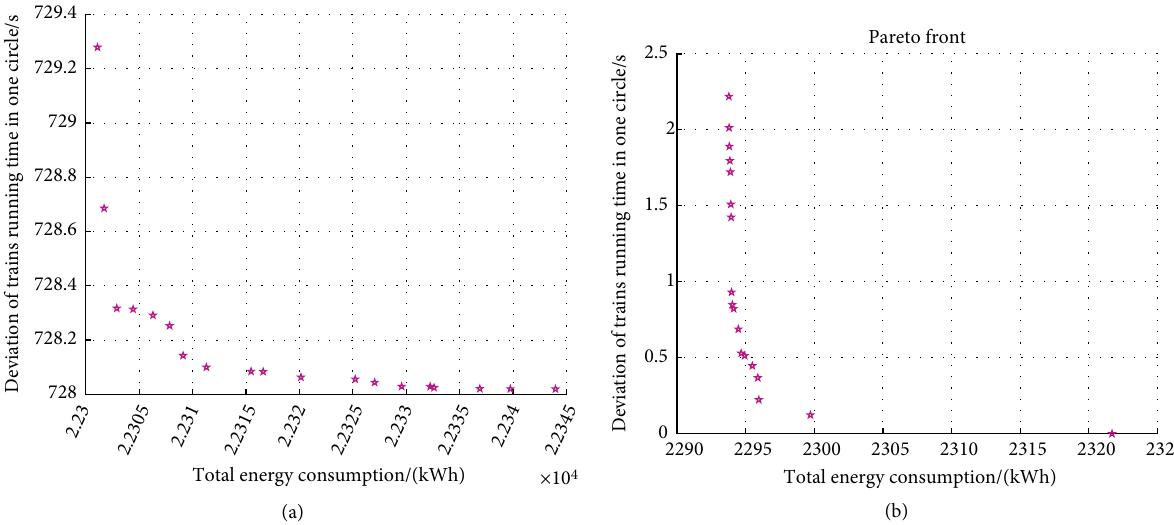
Figure 15: The Pareto front under and OIC = 0.2. (a) The Pareto solutions of the OEST. (b) The Pareto solutions of the OQOST. 𝐺 = 150